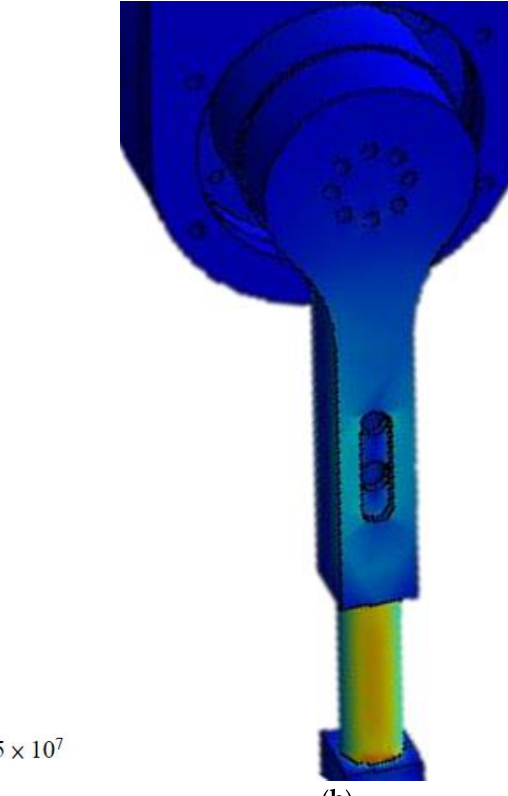
Figure 2. Final design of the LLRE-II.